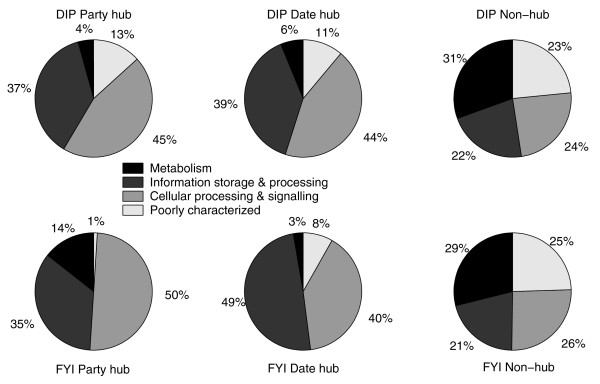
Functional classification of party hubs, date hubs and non-hubs. The functional classification was performed using KOG [19]. This classification consists of four main functional groups: metabolism; information storage and processing; cellular processes and signaling; and poorly characterized. Unnamed proteins have been excluded, although this is fairly common among the non-hub proteins.